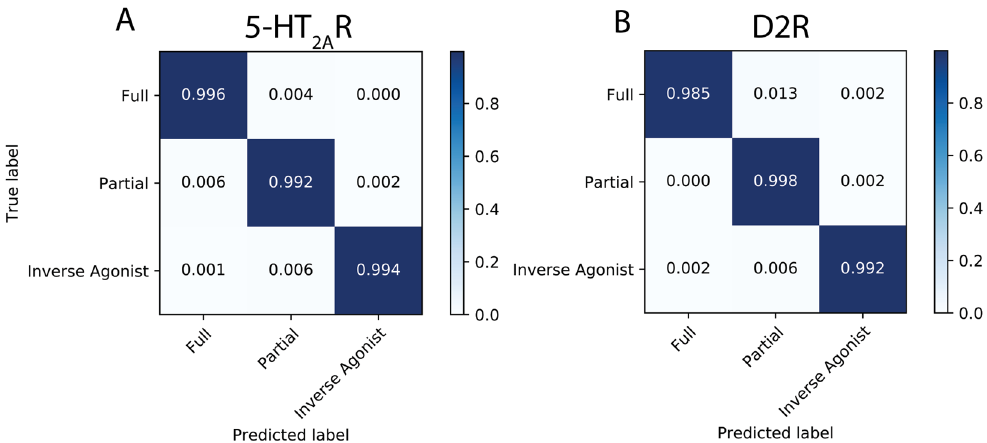
Figure 4. Results of the classification for the test set of the 5-HT 2A R ( A ), and D2R ( B ). The coded coloring and numbers show the proportion of times the neural network predicted correctly a class label (diagonal elements), and the extent to which it failed to correctly predict the class label (off-diagonal elements) by confusing it with another class.